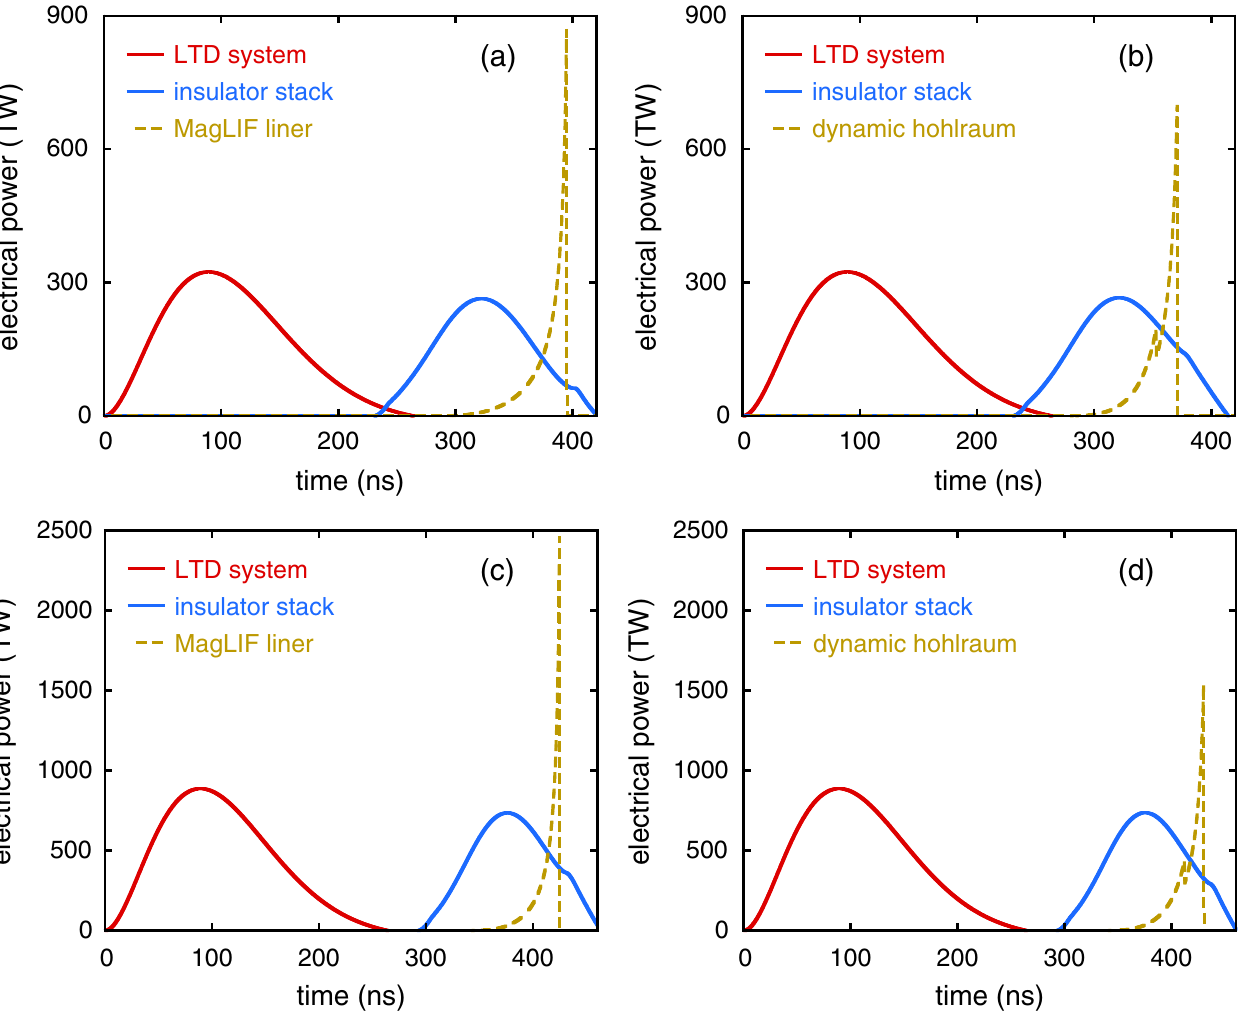
FIG. 9. Simulated electrical-power time histories at the output of the LTD system, the input to the insulator stack, and the liner for (a) a Z-300 shot conducted with a MagLIF load; (b) a Z-300 shot conducted with a dynamic hohlraum; (c) a Z-800 shot conducted with a MagLIF load; and (d) a Z-800 shot conducted with a dynamic